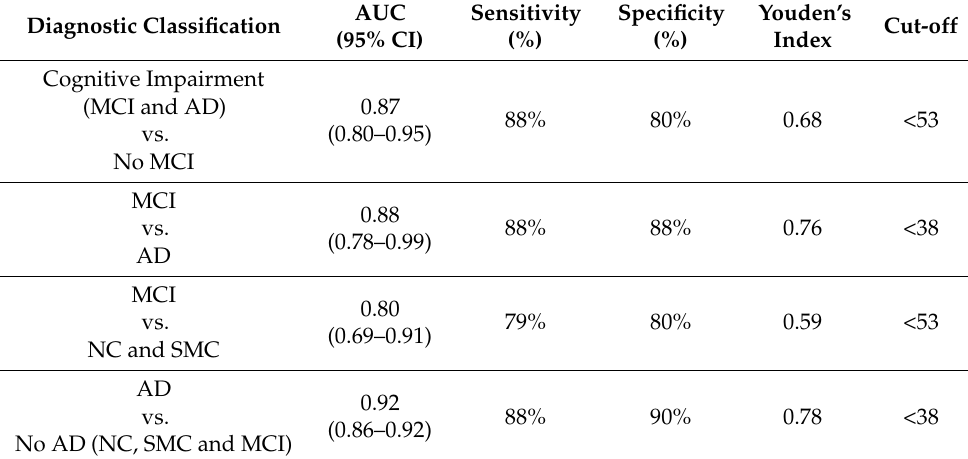
Table 3. Diagnostic properties of the Persian version of the Quick Mild Cognitive Impairment screen (Q mci -Pr), including optimal cut-off